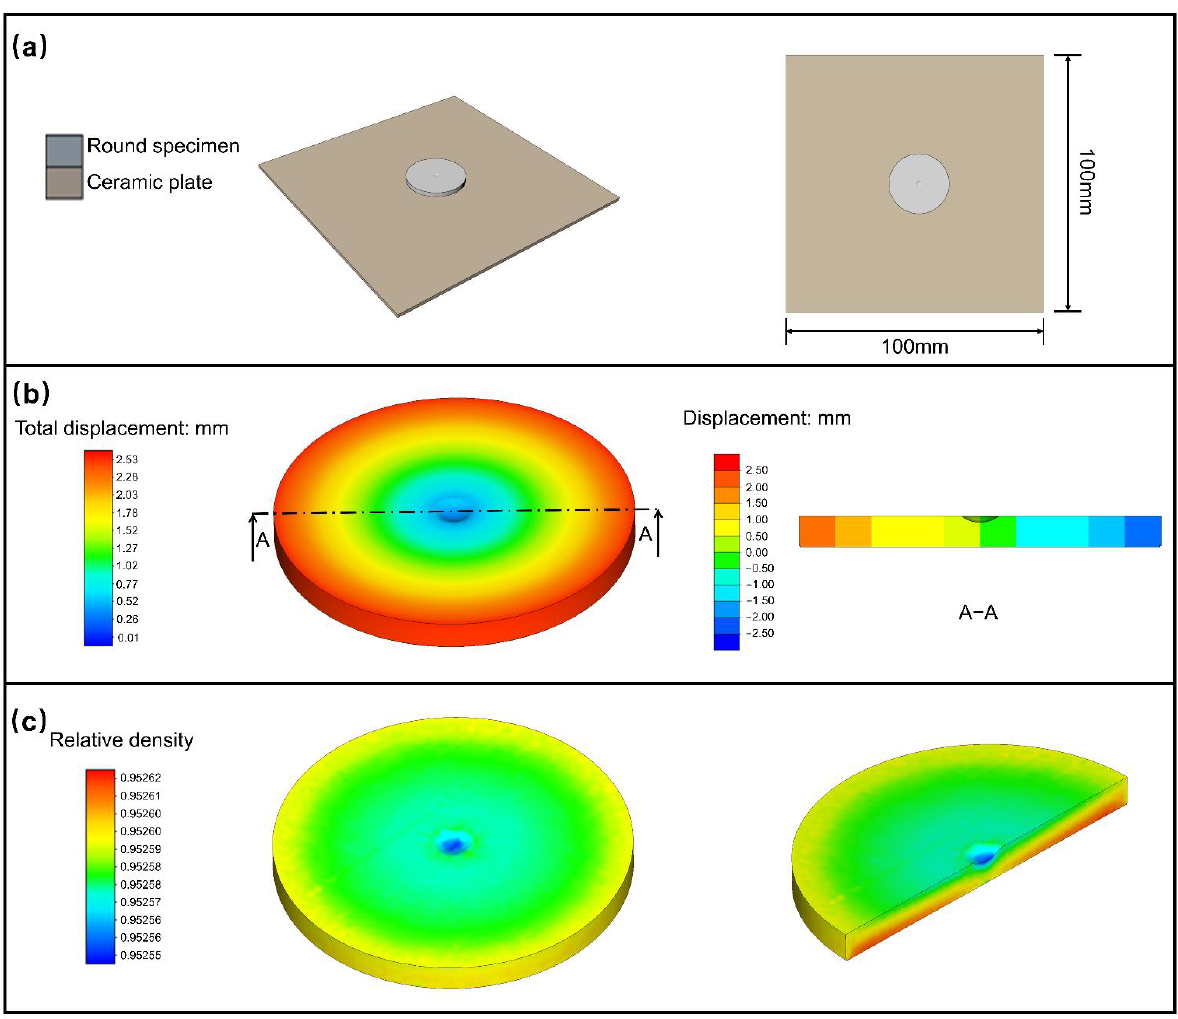
Figure 4. Simulation of round specimen for Ti-6Al-4V. ( a ) Layout, ( b ) total displacement, and ( c ) relative density.